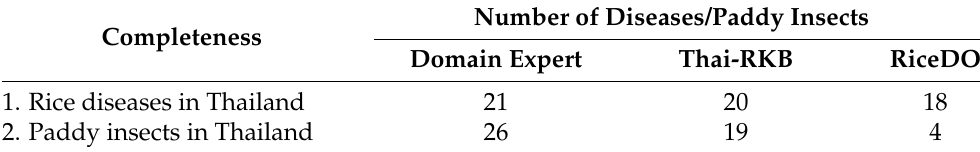
Table 6. RiceDO’s completeness (number of diseases and paddy insects).